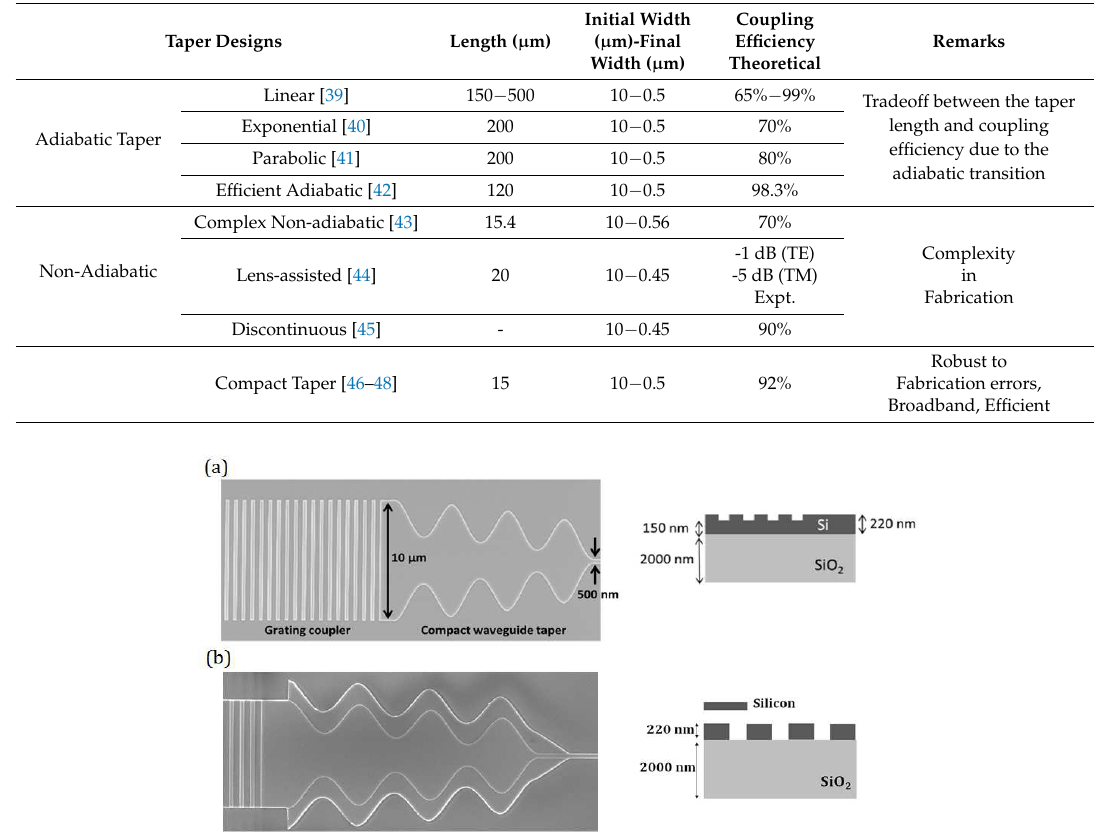
Figure 11. SEM image of a compact taper along a linear grating coupler for 1.55 µ m TE polarization for ( a ) SOI ridge waveguide ( b ) SOI wire